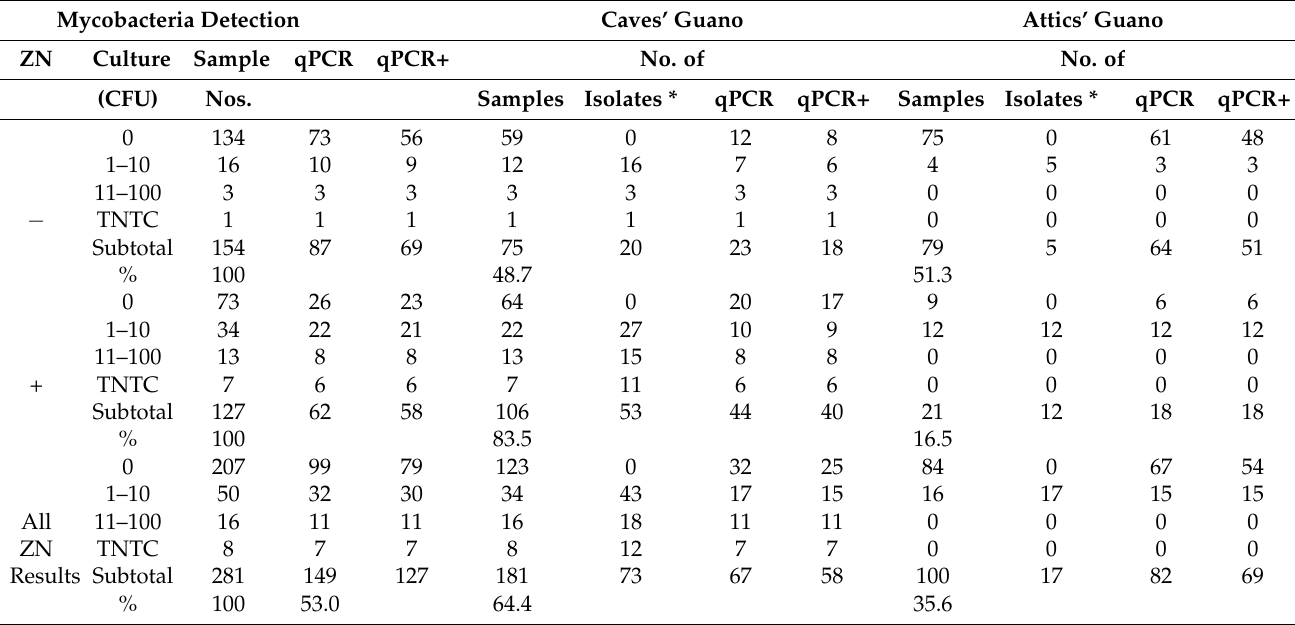
Table interpretation. ZN = microscopy examination after the Ziehl–Neelsen staining in at least 200 fields; − = negative examination; + sporadic acid-fast bacteria (AFB) detection; CFU = colony forming units; No. of examined guano samples by qPCR = quantitative PCR test; * in some samples, more isolates of different mycobacterial sp. and ssp. were